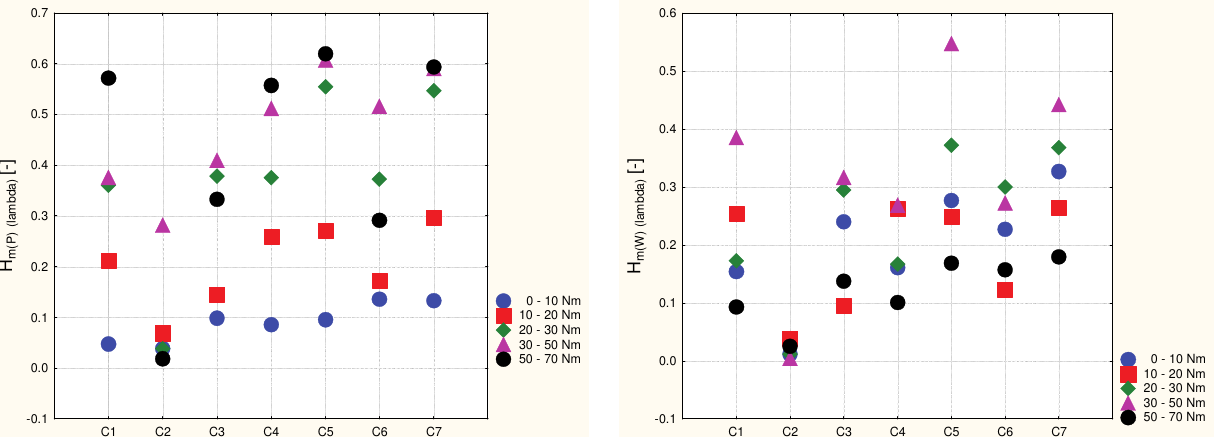
Fig. 5. Values of the information capacity index H m for λ and the transient state at n = 1100 r/min and a change of load from T tq = 0 Nm to T tq = 70 Nm: P – delayed angle of injection advance; W – accelerated angle of injection advance; C 1 – C 7 – combinations of illustrative